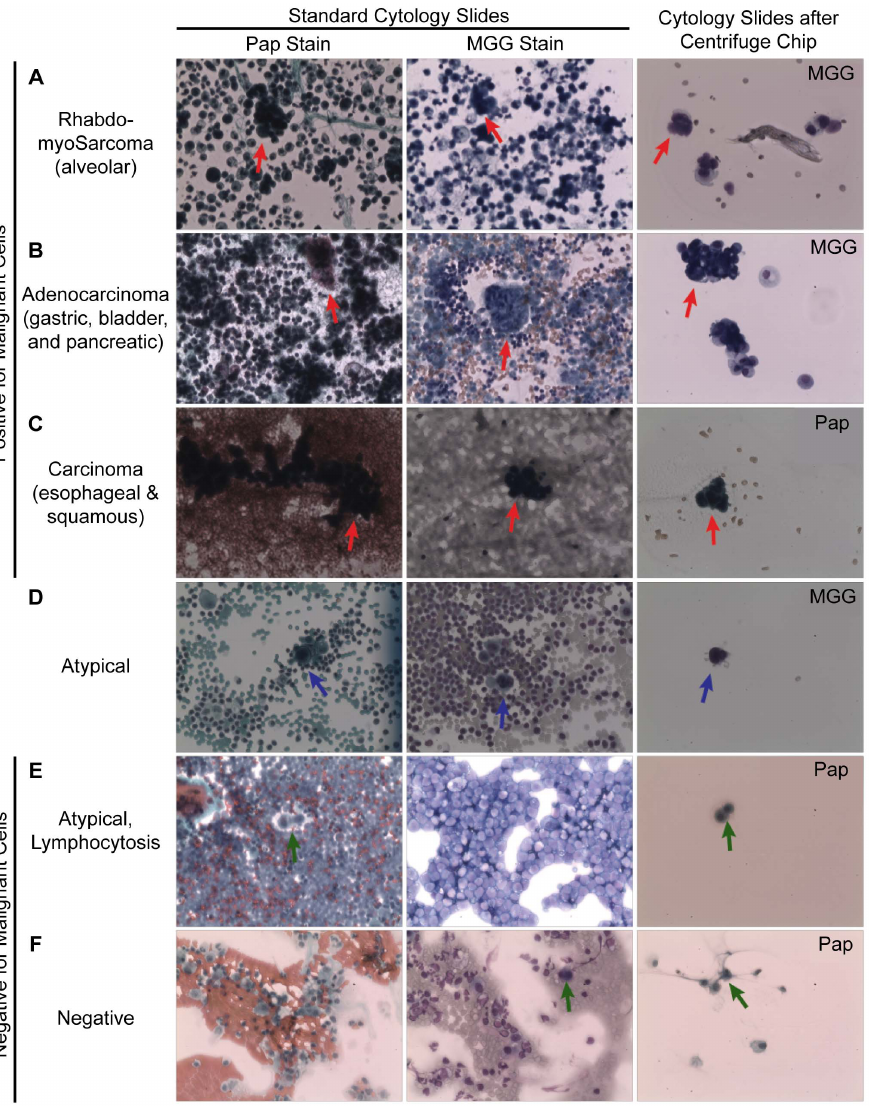
Figure 4. Reduced Background Cytology Slides When Prepared Using the Centrifuge Chip. Unprocessed patient samples are prepared with traditional cytological techniques using Papanicolaou (Pap) and May-Grunwald–Giemsa (MGG) stains. Cells collected from samples processed with Centrifuge Chip were also made into cytology slides. In all samples, malignant and mesothelial cells are found amongst a cellular background of immune cells in standard slides while little background is observed in the Centrifuge Chip slide. In samples diagnosed as ‘positive for malignancy’, single and clumped malignant cells (red arrows) are retrieved following the Centrifuge Chip. In patients diagnosed as ‘negative for malignancy’, mesothelial cells (green arrows) were found amongst a background of blood cells in standard slides, compared to no blood cell background upon Centrifuge Chip Processing. Samples diagnosed as atypical contained cells which resembled either malignant or mesothelial cells (blue arrows). Images obtained at 200 6